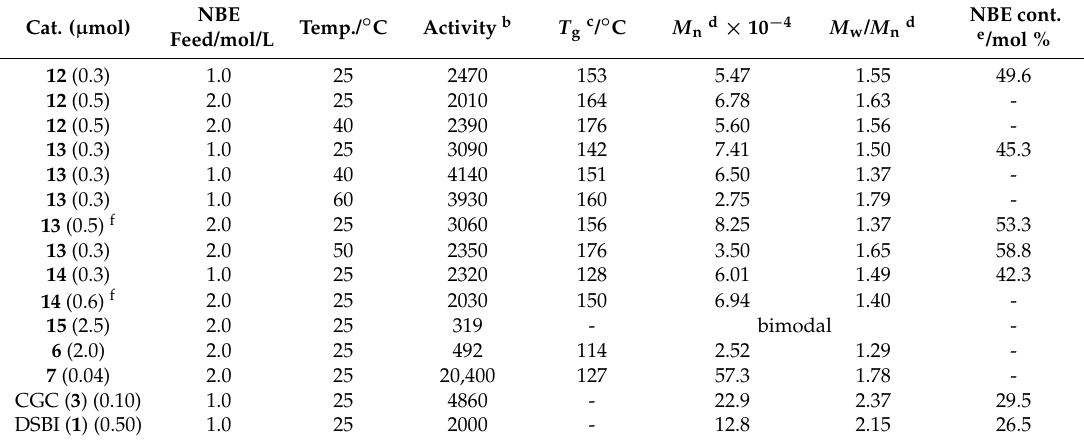
Table 5. Copolymerization of ethylene with norbornene (NBE) by Cp’TiCl 2 (OAr) (Cp’ = Cp, Ar = 2,6-Cl 2 C 6 H 3 ( 12 ), 2,4,6-Cl 3 C 6 H 2 ( 13 ), C 6 Cl 5 ( 14 ), or 2,6- i Pr 2 C 6 H 3 ( 15 ); Cp’ =